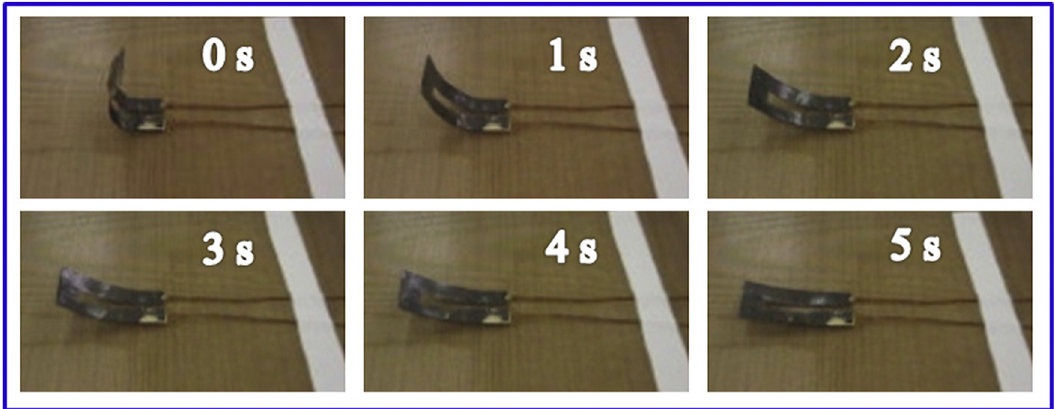
Figure 6: Shape recovery process of epoxy/reduced graphene oxide paper - based shape memory nanocomposite under applied voltage of 6 V ( 98 ) . Reproduced with permission from